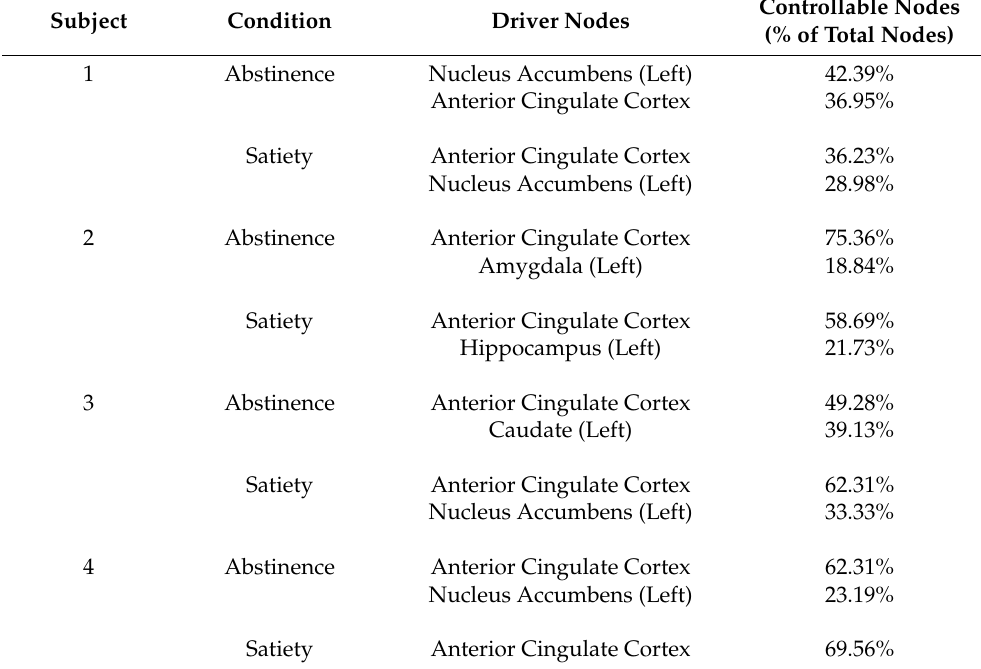
Table 2. Two most-dominant driver nodes for abstinence and satiety across all subjects. The percentage- controllable nodes show the ratio of average number of nodes across all brain-connectivity states controlled by the driver node and the total number of brain regions (23). For subjects 4 and 5, the second node is not shown for the satiety condition as no other node than the ACC was a common driver across all brain-connectivity